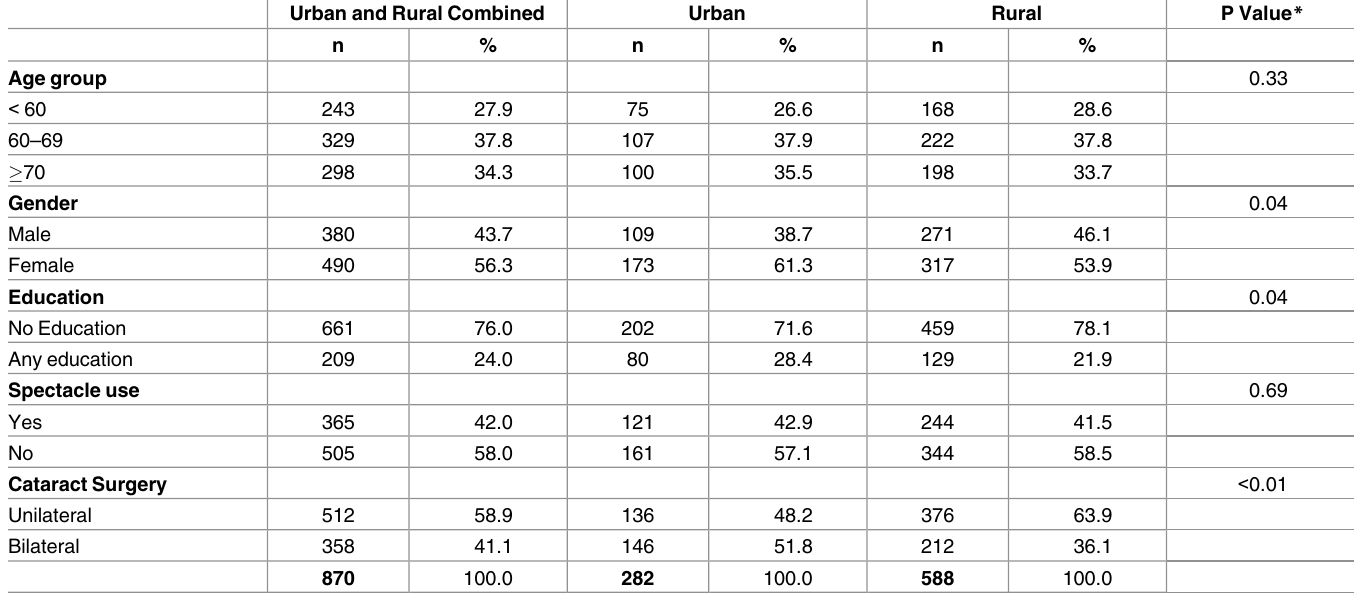
Table 1. Characteristics of the sample (n =